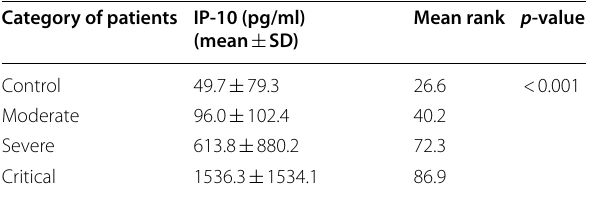
Table 1 Association of serum level of IP-10 (pg/ml) among different categories of COVID-19 patients and healthy controls ( n 112) = Category of patients IP‑10 (pg/ml) (mean